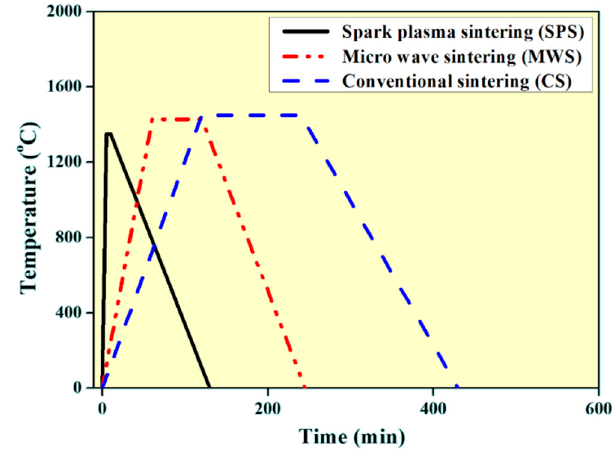
Figure 1. Temperature profiles observed for different processing routes (conventional sintering, microwave sintering and spark plasma sintering).